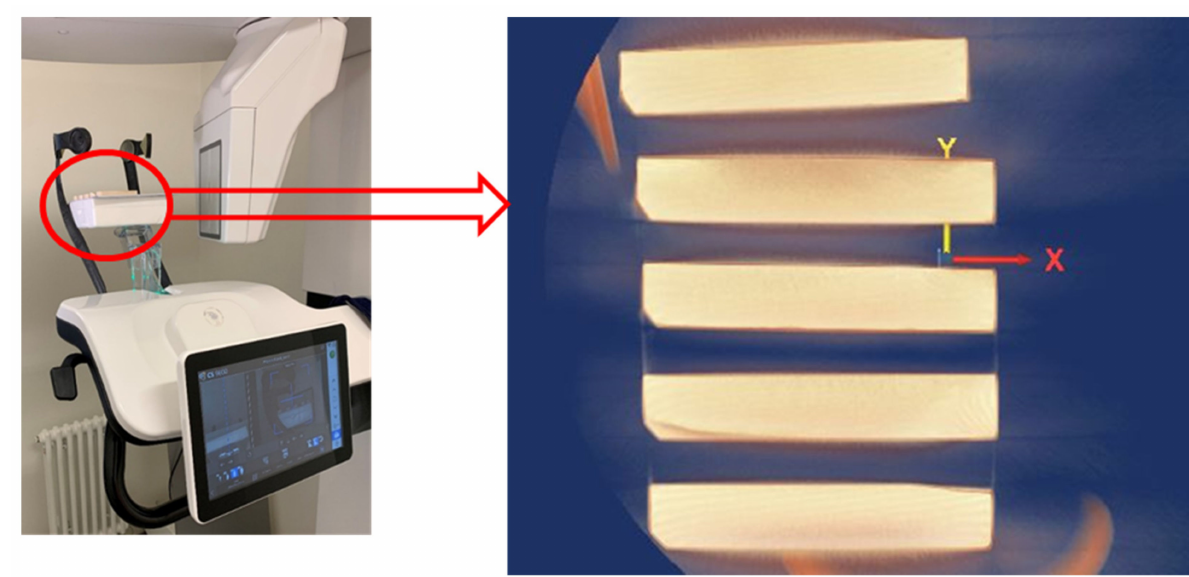
Figure 7. Samples prior to CT